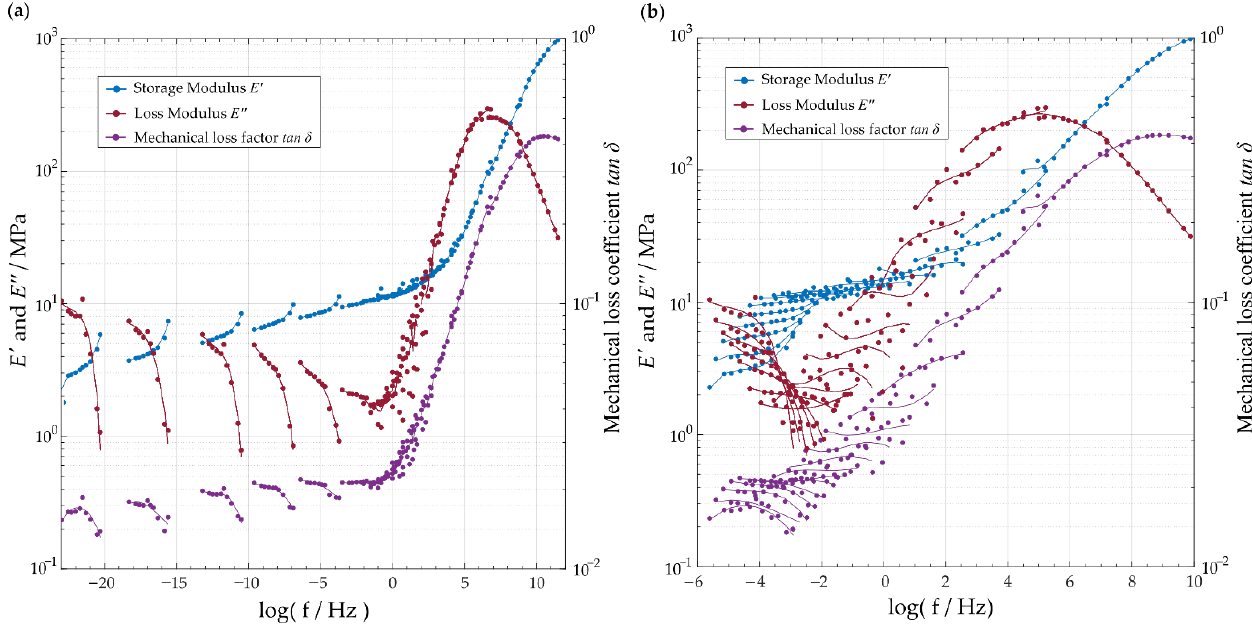
Figure 6. Master curves generated by shifting 𝐸′ and 𝐸′′ using the TTS principle with respect to a reference temperature of 20 °C: ( a ) using an eighth-degree polynomial approximation and ( b ) the WLF shift factors.